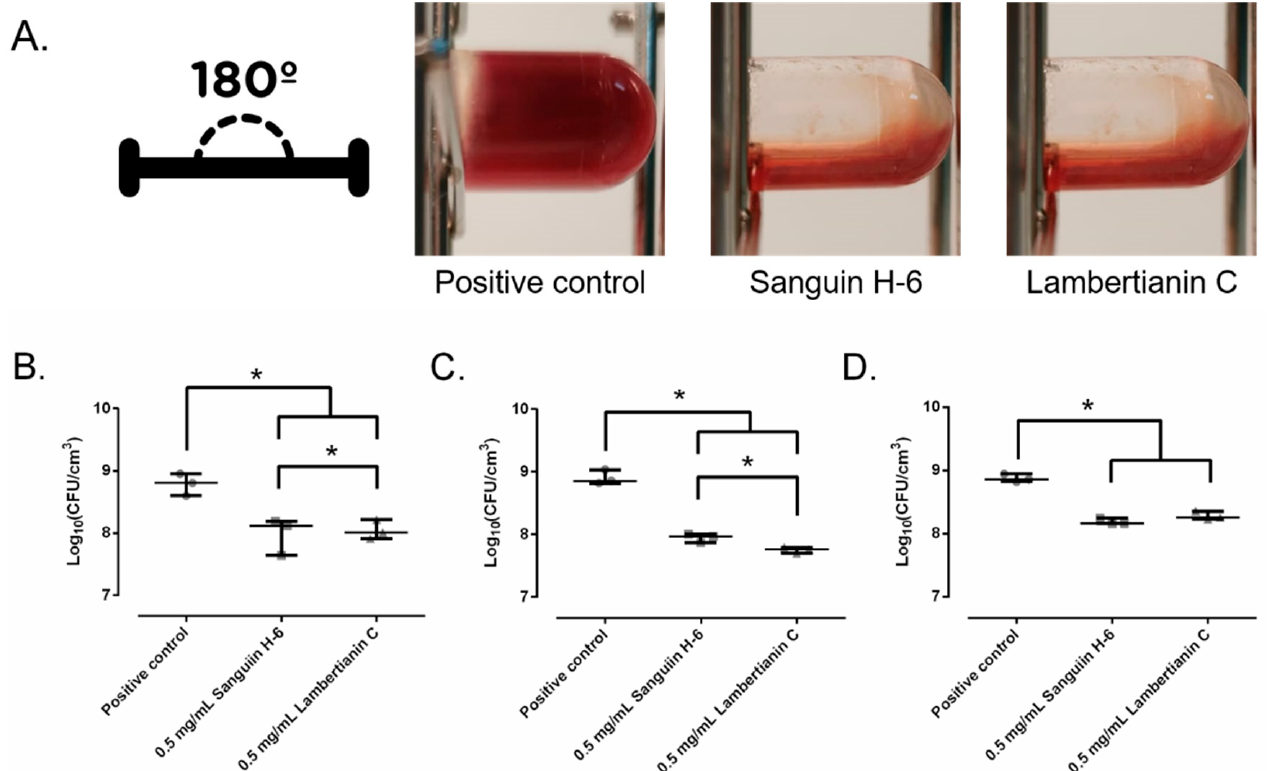
Figure 7. Macroscopic appearance of wound-like medium after the SAP231 biofilm development ( A ). The effect of sanguiin H-6 and lambertianin C at different concentrations on SAP231 ( B ), MRSA1 ( C ), and MRSA2 ( D ) biofilm development in wound-like medium:. *: p -value < 0.05 for Wilcoxon test.